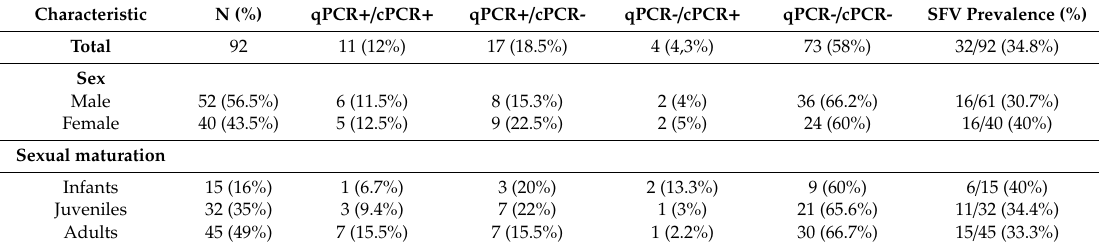
Table 1. Comparison of simian foamy virus (SFV) prevalence estimates by quantitative PCR (qPCR) and conventional PCR (cPCR) in relation to sex and the sexual maturity of L.